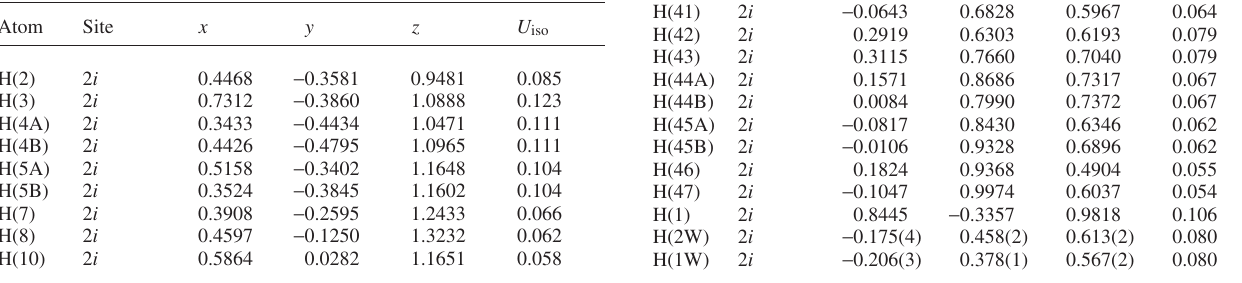
Table 2. Atomic coordinates and displacement parameters (in Å 2 ) .